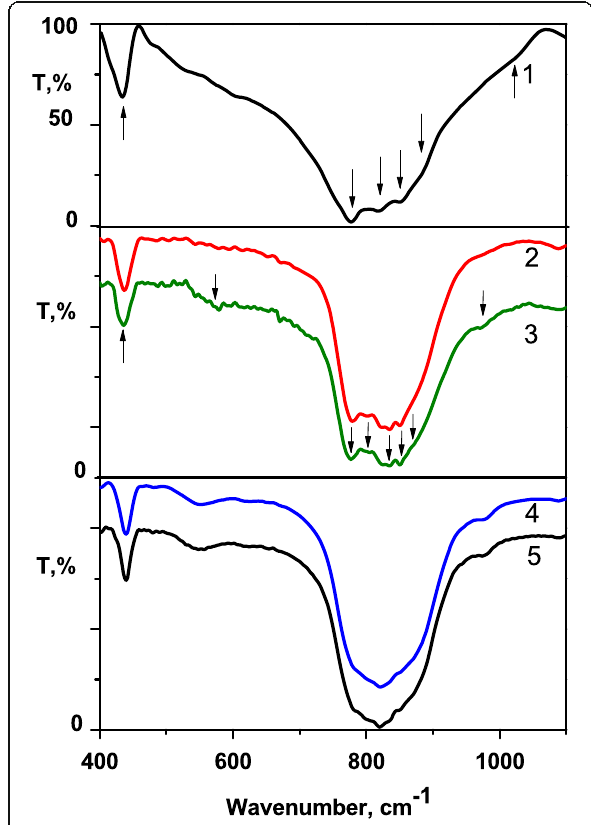
Fig. 4 IR absorption spectra of the LaVO4 ( 1 ), La0.9Ca0.1VO4 ( 2 ), La0.8Ca0.2VO4 ( 3 ), La0.8Eu0.1Ca0.1VO4 ( 4 ), and La0.6Eu0.2Ca0.2VO4 ( 5 )